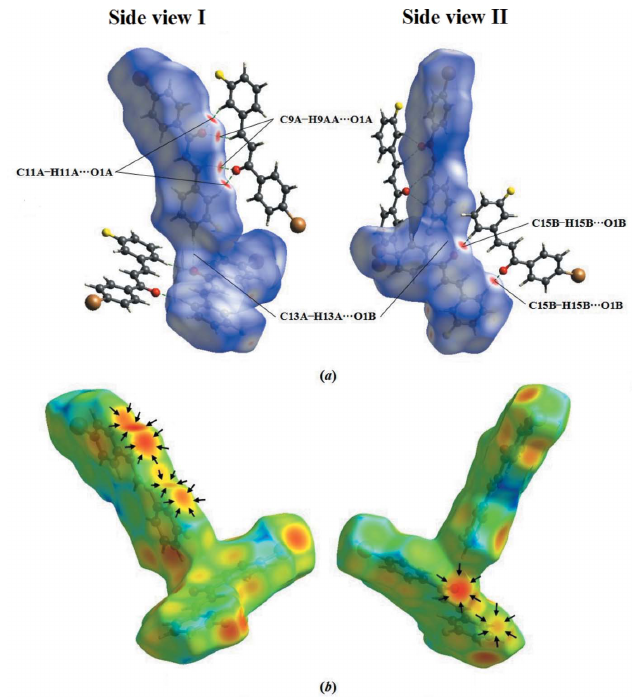
Figure 4 Hirshfeld surfaces of the title compound mapped over d norm and d e .